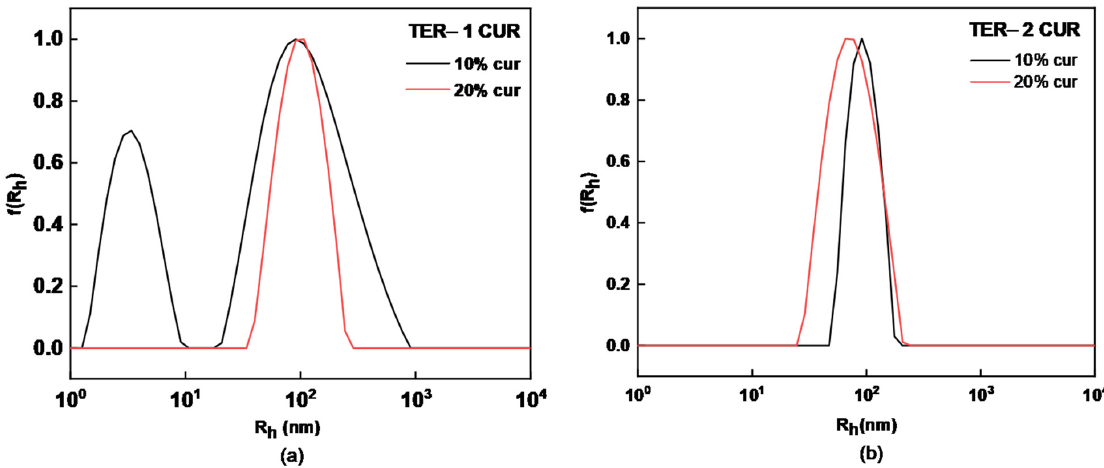
Figure 9. ( a ) TER-1 and ( b ) TER-2 terpolymer mixed aggregates with curcumin encapsulation 10% w / w and 20% w / w from THF protocol.